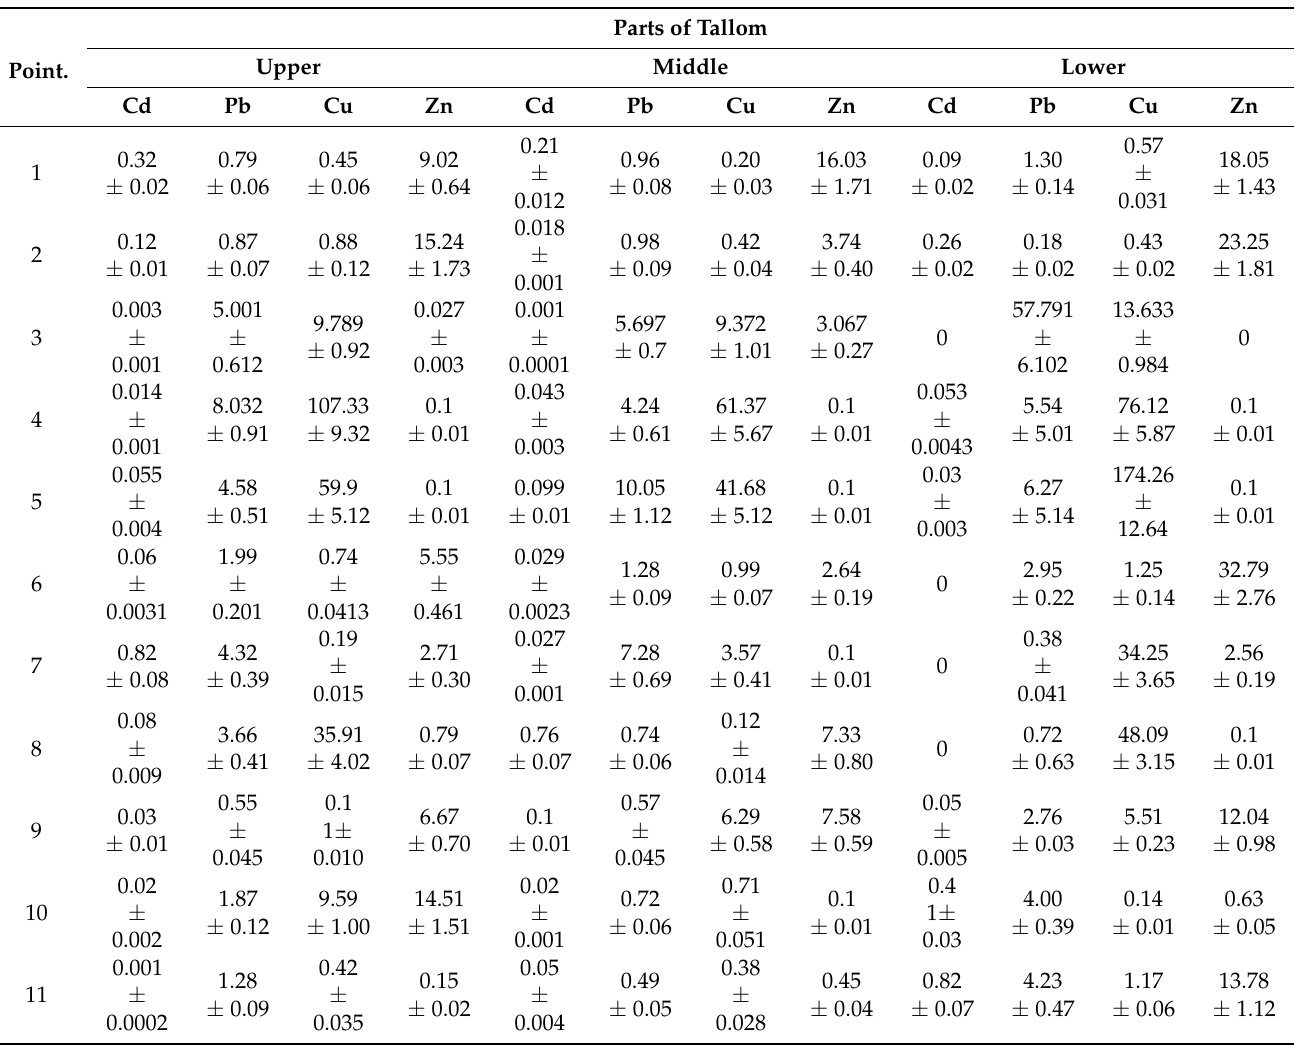
Table 2. Metal content in lichen beds (mg/kg dry